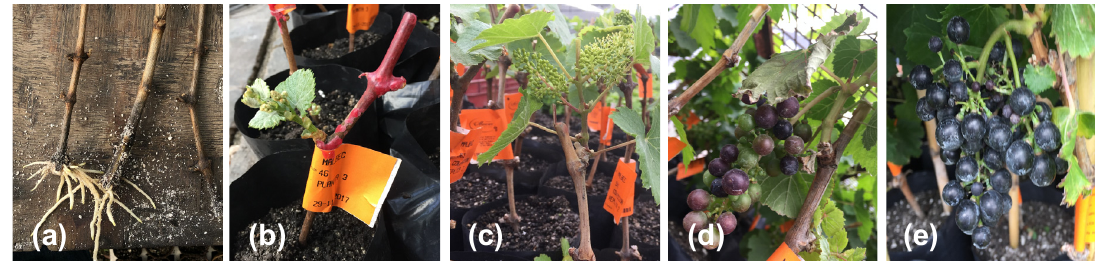
Figure 1. Developmental stages of ‘Malbec’ fruiting cuttings. ( a ) cuttings showing root development on removal from the heated container after four weeks; ( b ) budburst; ( c ) fruit set; ( d ) veraison; ( e ) the same cluster at harvest.